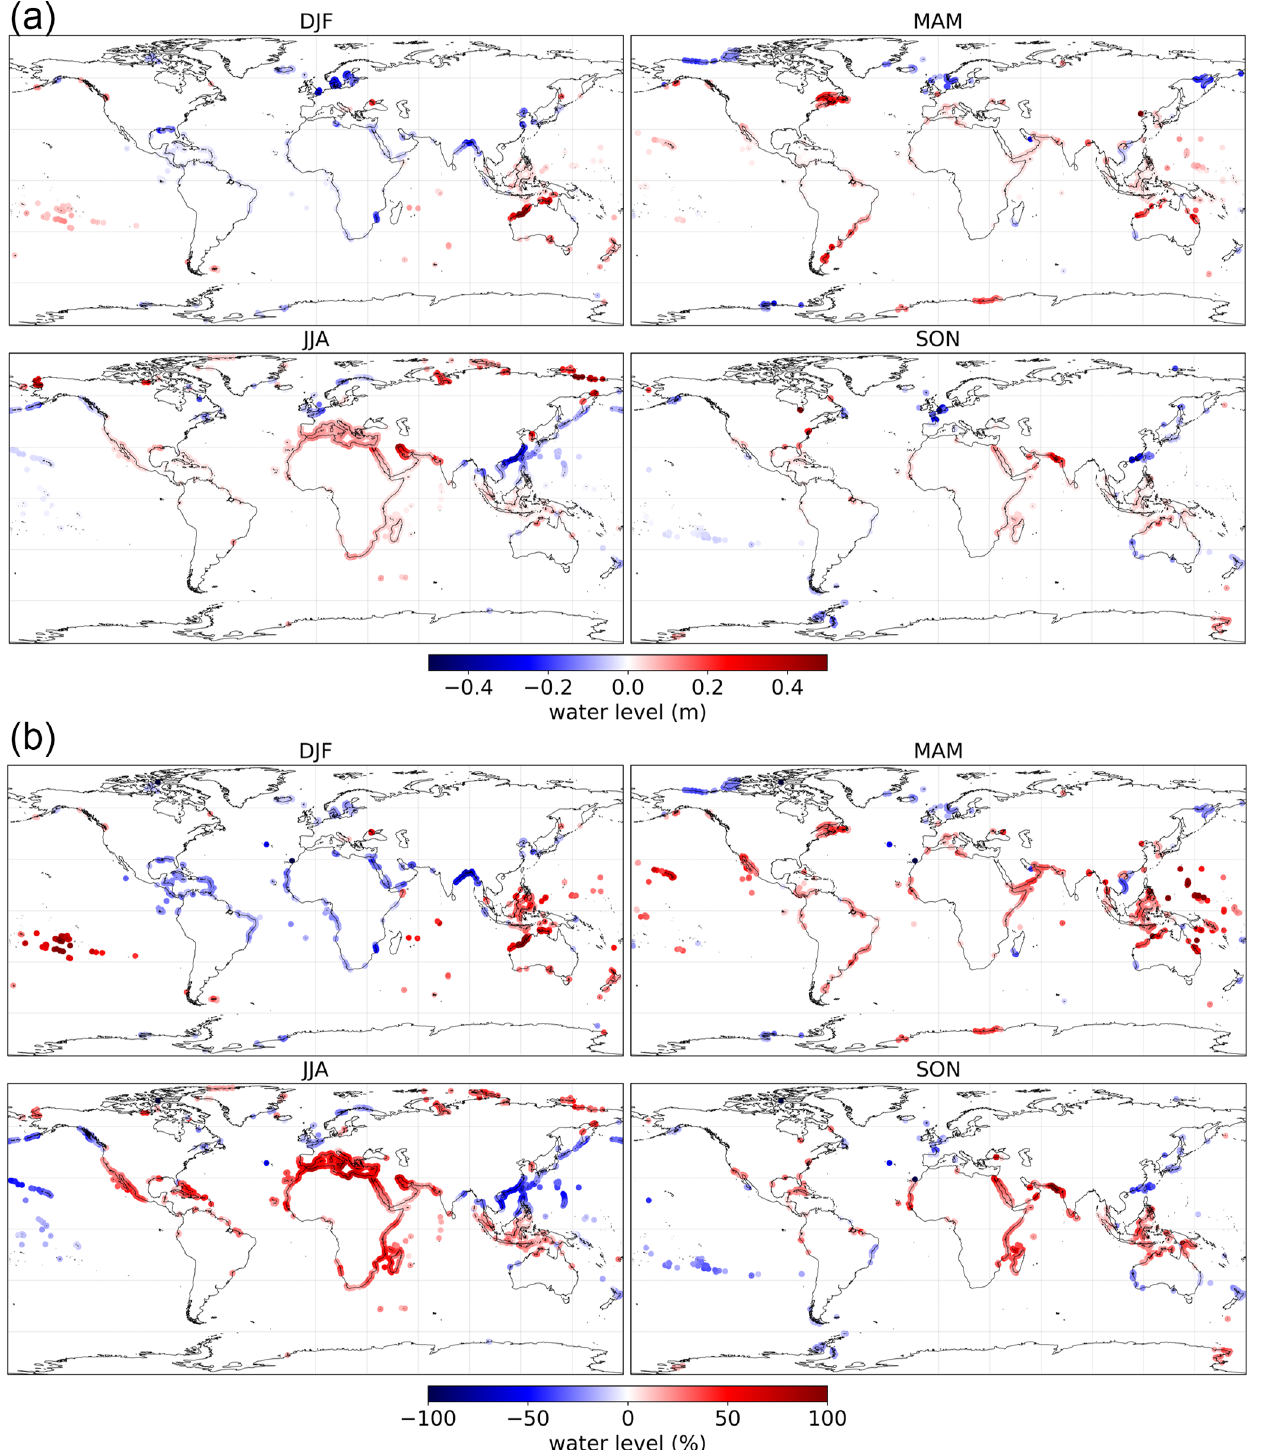
Figure 4. Anomalies (LIG minus PI) in sea level extremes at the 10-year return period, as (a) absolute and (b) percentage values. Only values for which the 95% uncertainty bands of the distributions of each climate do not overlap are